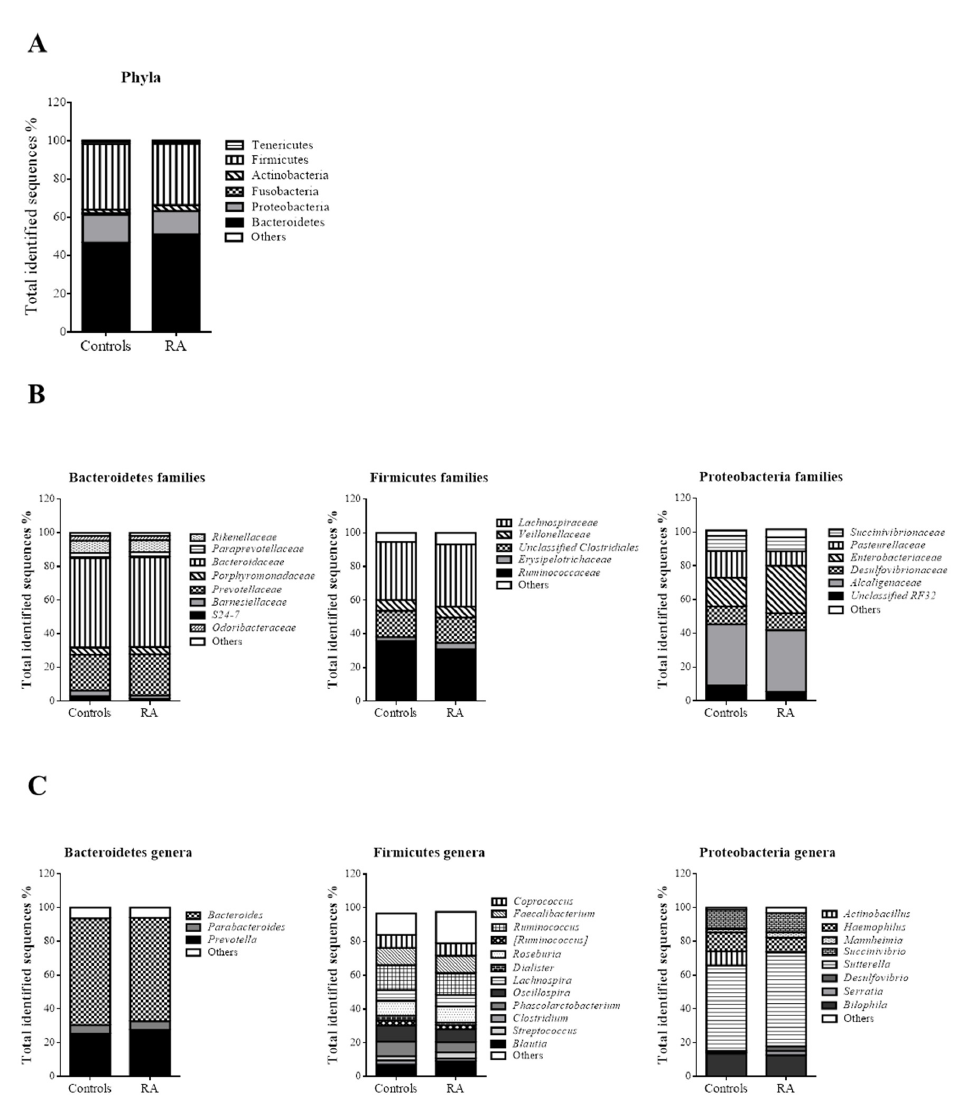
Figure 2. ( A ) Phylogeny at phyla in controls and RA patients. ( B ) Microbial community structure at the family level in fecal samples of controls and RA patients (Bacteroidetes families, Firmicutes families and Proteobacteria families). ( C ) Relative abundance of predominant genera in the microbiota of controls and RA patients (Bacteroidetes genera, Firmicutes genera and Proteobacteria genera). Data are shown as a percentage of the total identified sequences per group.